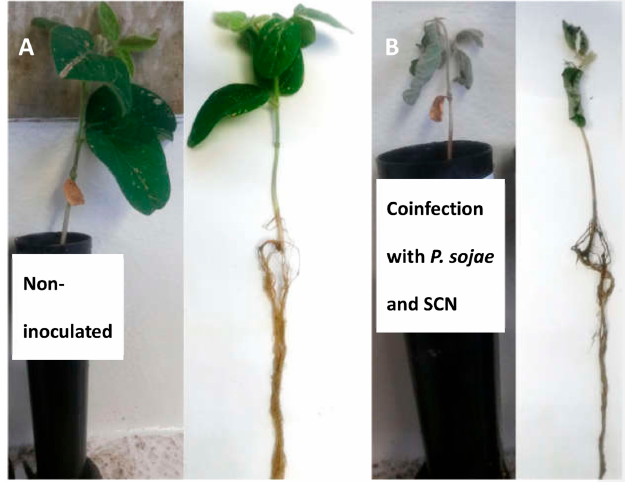
Figure 1. Phenotypic response of soybean plants (cv. Williams) at 35 days after inoculation following coinfection by P. sojae (PS-15-TF3) and SCN ( A ) non-inoculated ( B ) coinfection with P. sojae (Ps-15- TF3) and SCN.